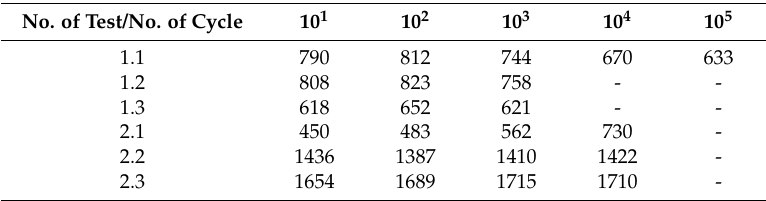
Figure 11. Resilient modulus change during the tests. Table 4. Resilient modulus Mr (in kPa) for selected cycles of the tested RCA.